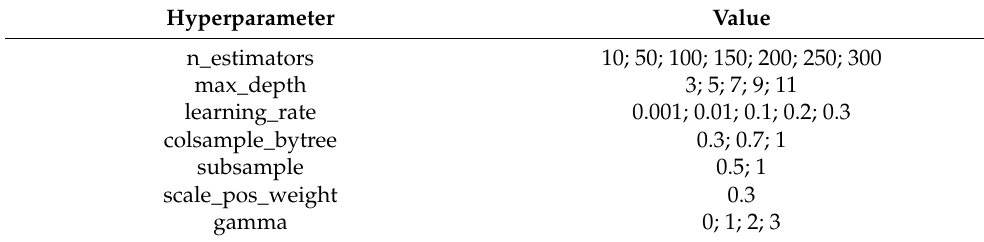
Table 5. Tested hyperparameters of the XGBClassifier classifier.